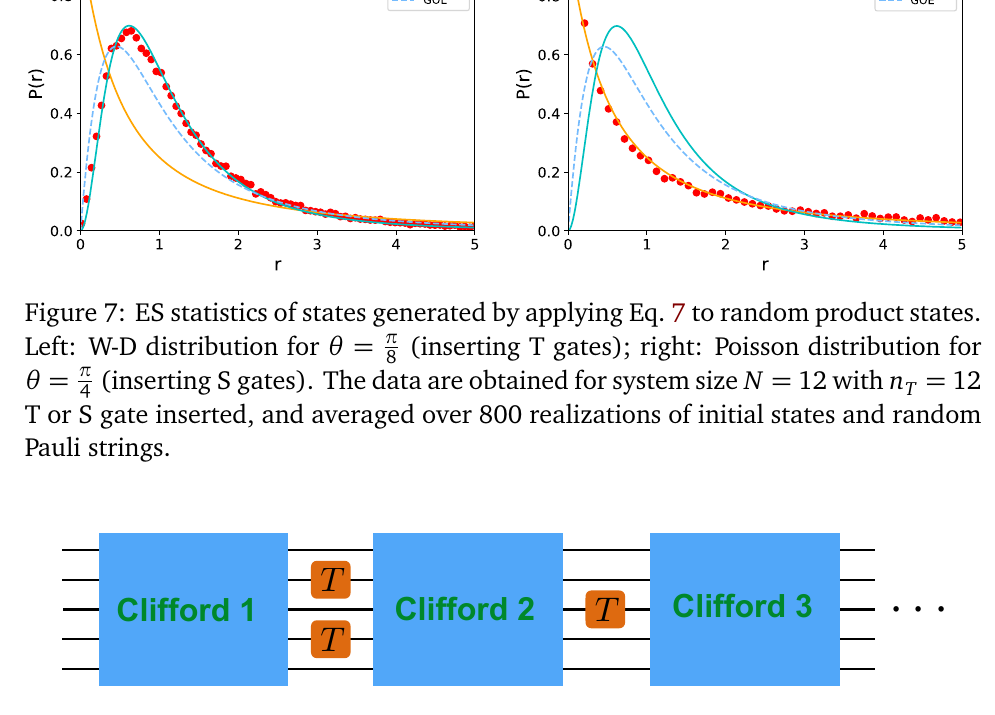
Figure 8: A potential architecture for universal quantum computing, where only a small number of T gates are added at largely spaced